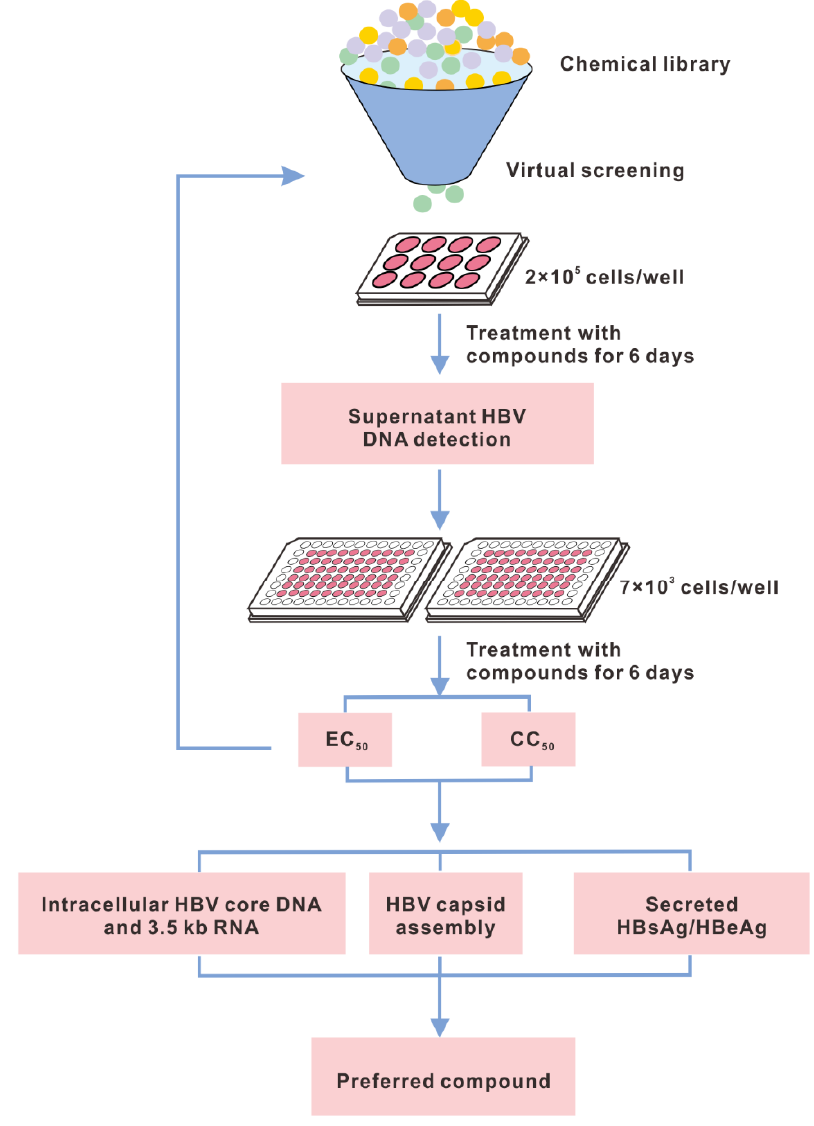
Figure 1. Schematic depiction of the primary screening workflow. HepAD38 or HepG2-HBV1.3 cells were treated with compounds (20 μM) for 6 days, then viral nucleic acids and proteins were de- tected.